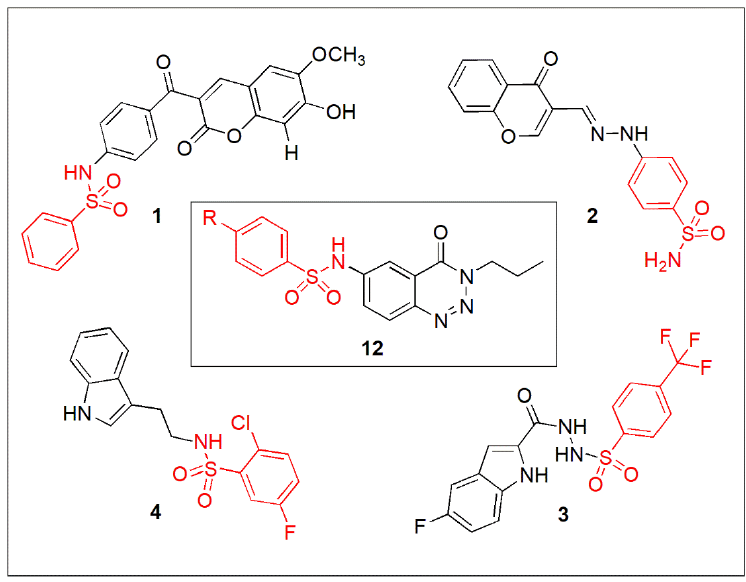
Figure 1. Reported structures of heterocyclic sulfonamides as alpha-glucosidase inhibitors.